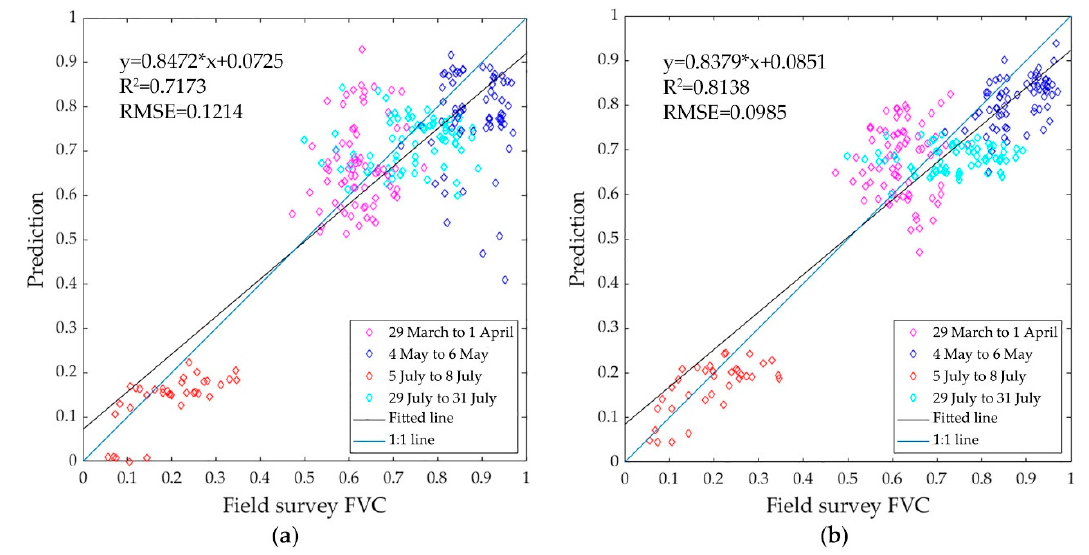
Figure 11. Validation of the prediction from FC ( a ) and CF ( b ) based on the field survey FVC data.